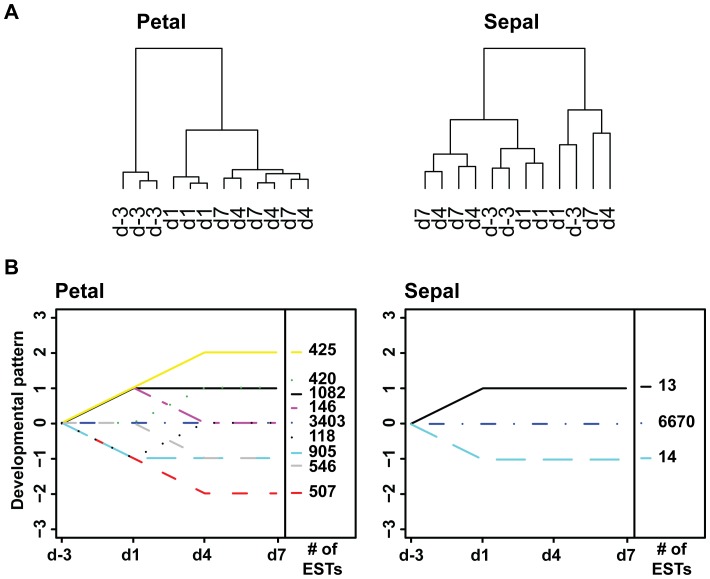
Developmental rearrangements in gene expression of snapdragon petals and sepals.(A) Cluster dendrogram showing samples collected at the four stages of petal and sepal development. Samples were clustered according to their gene expression profile. (B) Grouping of expressed sequence tags (ESTs) based on their developmental profile. Using a one-way ANOVA, three hypotheses were tested: H0: µd-3 = µd1, H0: µd1 = µd4, H0: µd4 = µd7. A score was attributed for each test. If the gene expression was not significantly different (p-value>0.05), the score = 0. If it was significantly up-regulated (p-value<0.05), the score = 1. If it was significantly down-regulated (p-value<0.05), the score = −1. Genes were grouped based on the combination of scores for the three tests. The number of ESTs in each developmental pattern is indicated next to the graphs. Developmental expression profiles containing less than ten ESTs are not represented.